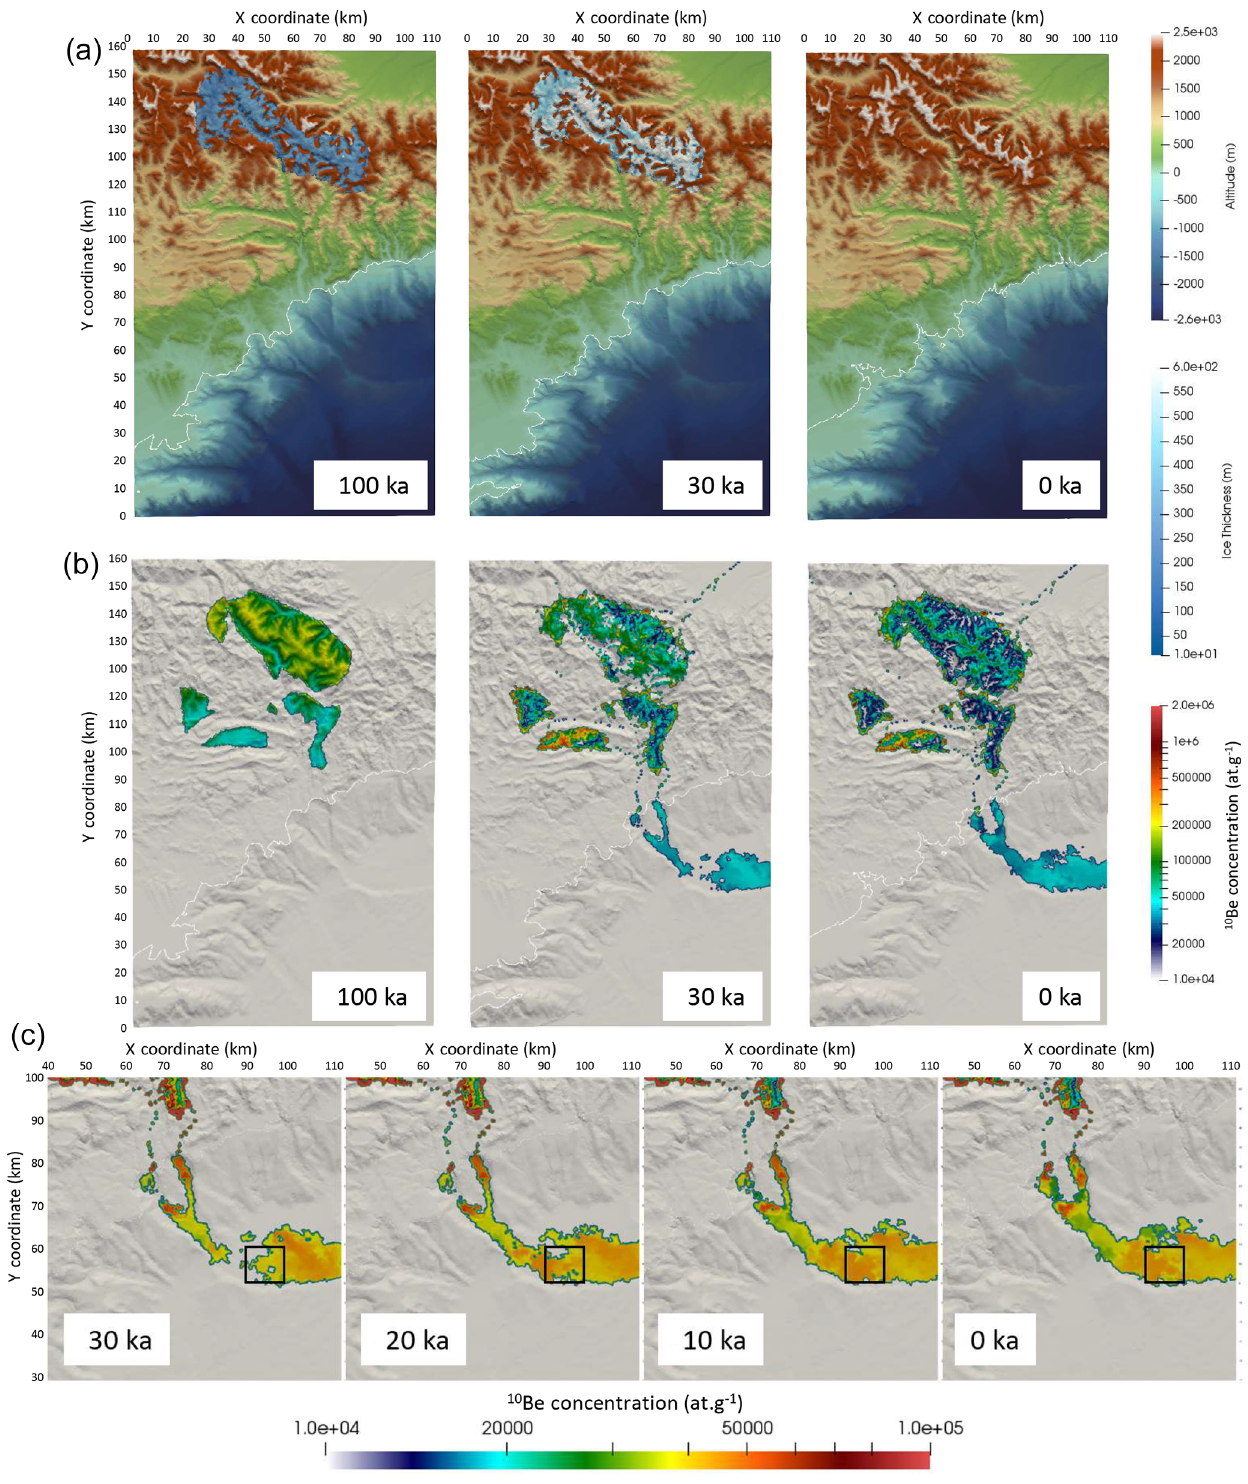
Figure 8. Stages of evolution of the reference model from 0 to 100kyr (model time counted forward, corresponding to 100 to 0ka in reality and on the figure time stamps). Upper panels (a) present the topography and ice thickness, middle panels (b) present the surface 10 Be concentration and lower panels (c) present a blow-up of the surface 10 Be concentration in submarine sediments in the last 30kyr, with an adjusted colour map. The solid rectangle in the lower panels indicates the area where average 10 Be MS has been computed (see results in Fig.